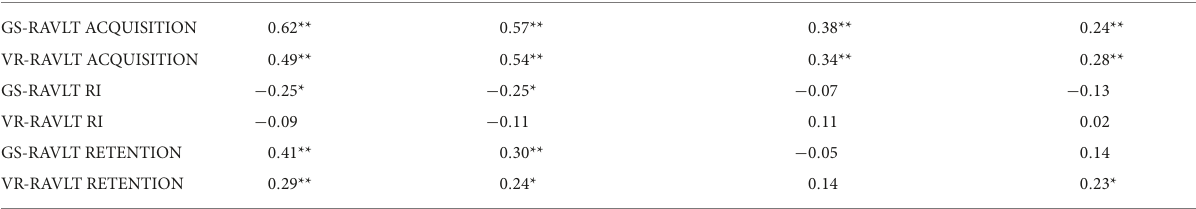
TABLE 3 Pearson correlations between the RAVLT outcome measures and four other neuropsychological tests.